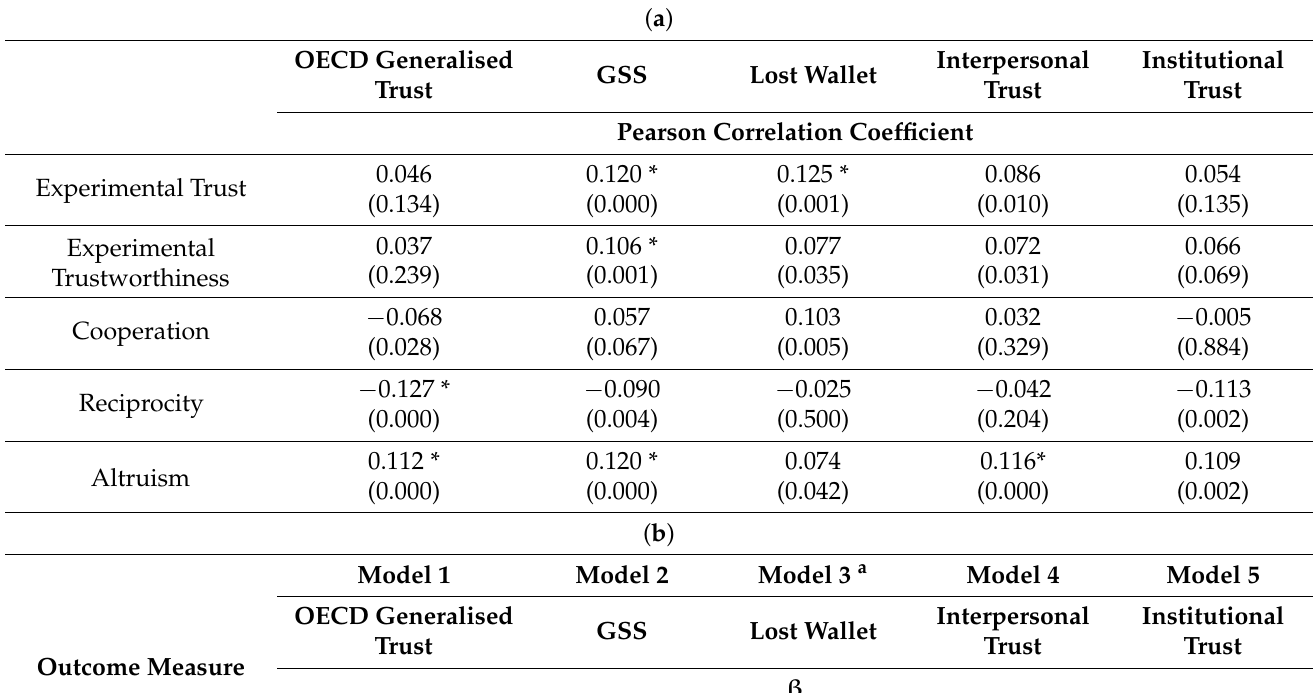
Table 3. ( a ) Correlation Analysis between self-reported and experimental social preference measures. ( b ) Regression Analysis with Experimental Trust as